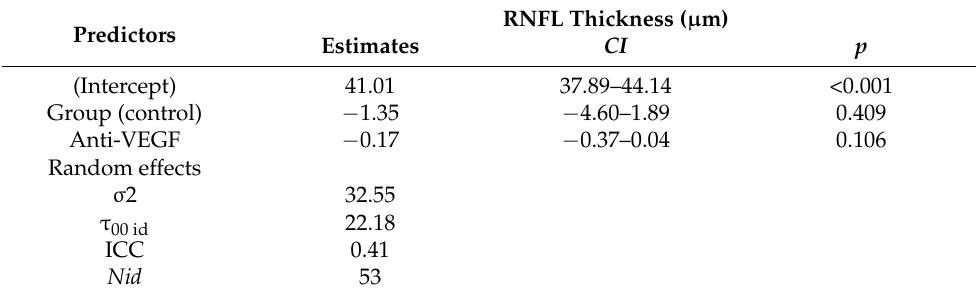
Table 1. Results of fitting model